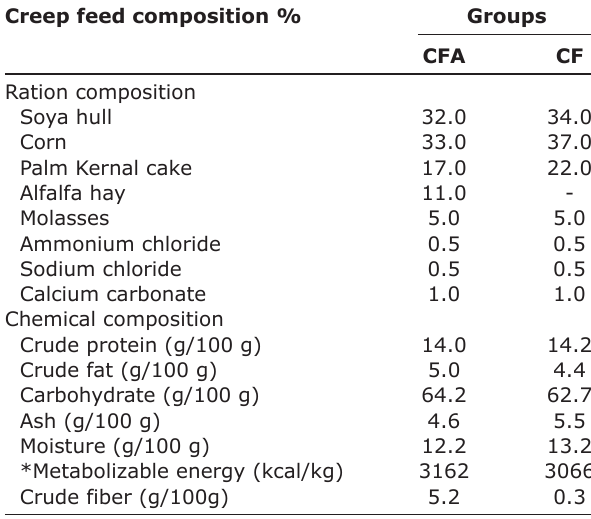
Table-1: Ration composition and chemical analysis of creep feeds fed to CFA and CF groups.